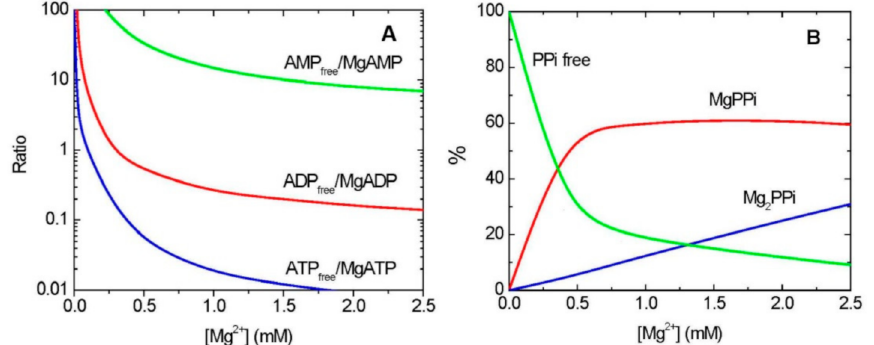
Figure 1. Effects of Mg 2+ on Mg-chelation with adenylates and PP i . ( A ) The ratios of free and Mg-bound adenylates, depending on [Mg 2+ ]. ( B ) The percentage of free and Mg-chelated PP i , depending on [Mg 2+ ]. All lines were drawn according to the values of stability constants for chelation of adenylates and PP i with Mg [15], using Origin software (OriginLab Corporation, Northampton, MA,